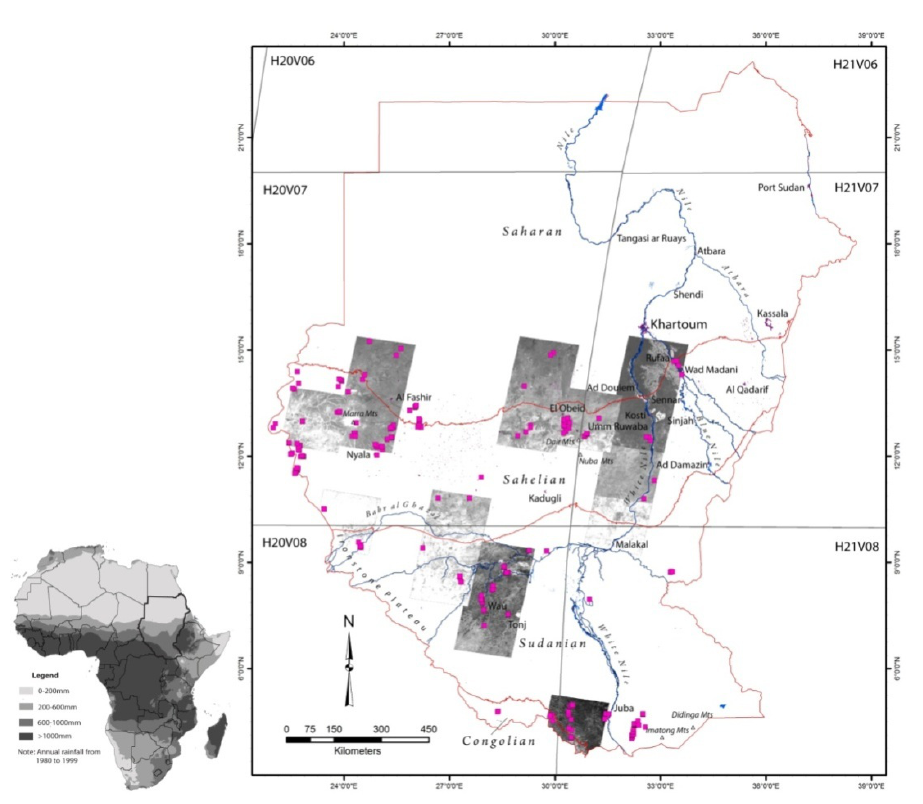
Figure 1. Distribution of the 287 sampling